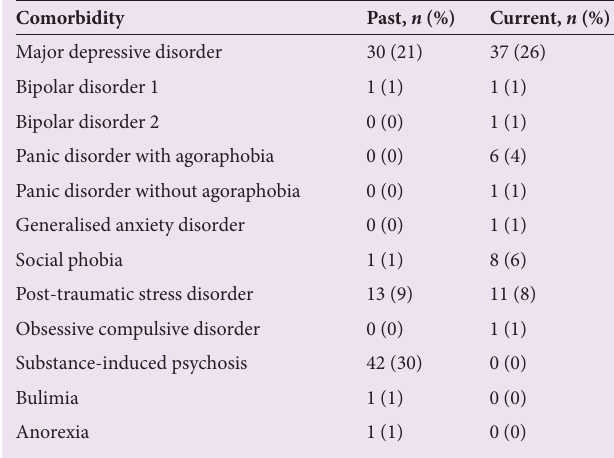
Table 4. Frequency of previous and current psychiatric comor- bidities in the sample ( N